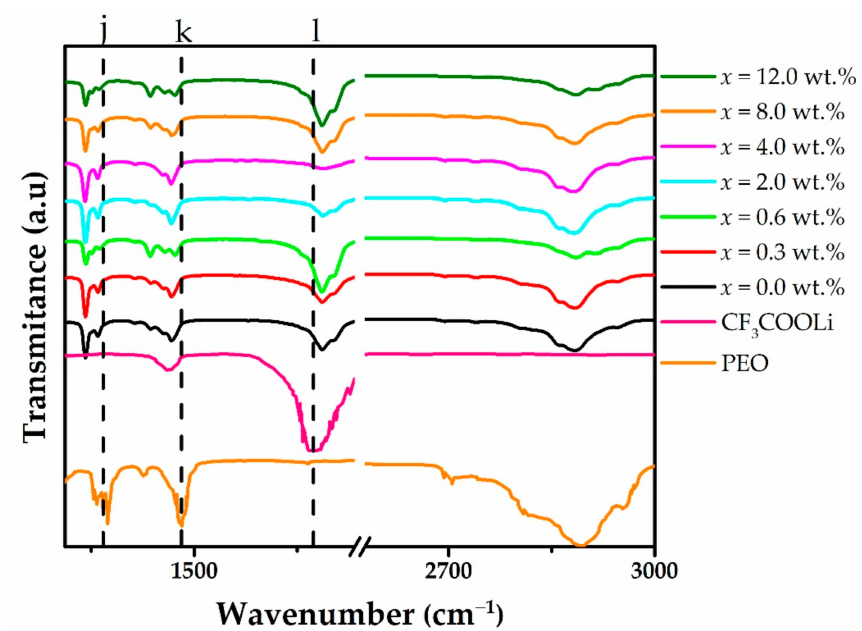
Figure 4. FTIR spectra for PEO, CF 3 COOLi, and different concentrations of MWCNT in the (PEO) 4 CF 3 COOLi electrolyte, for wavenumber ranging from 1312 to 3000 cm − 1 . The dotted vertical lines stand for some wavenumber: j = 1358 cm − 1 , k = 1470 cm − 1 ; l = 1673 cm − 1